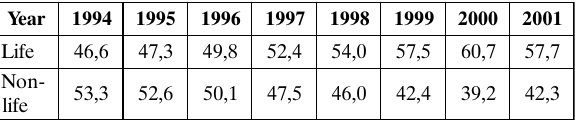
Table 6. Density and penetration indicators in Poland and Lithuania, 2002 /rotacidnI dnaloP yrtnuoC